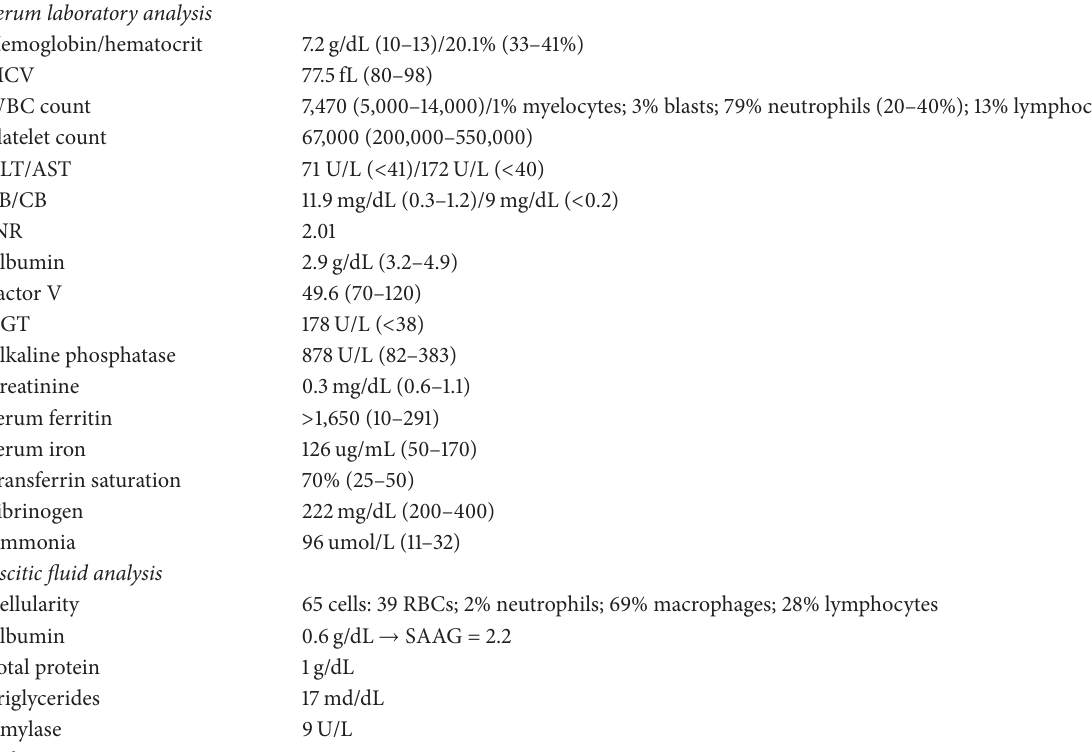
Table 1: Serum and ascites laboratory values on